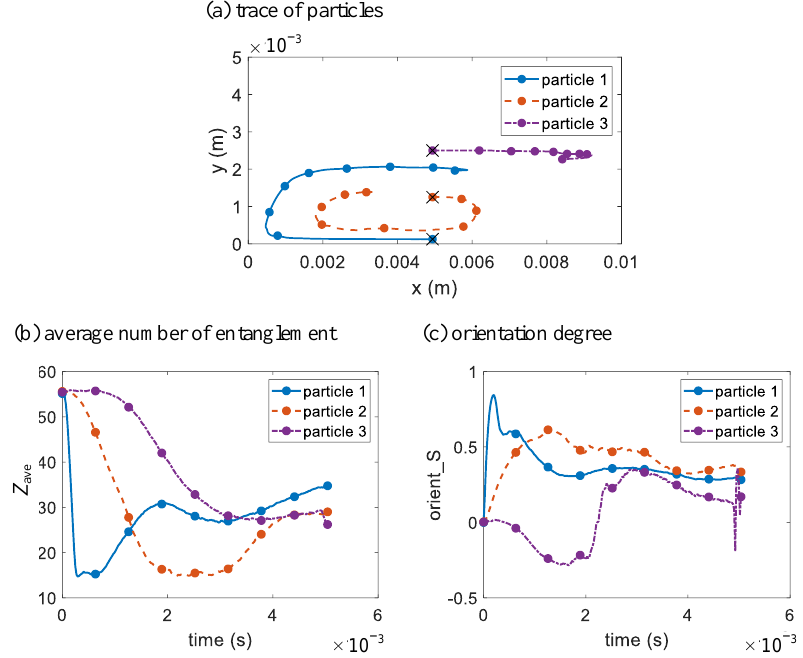
Figure 7. The multiscale simulation results of ( a ) particle traces and the changes in ( b ) average number of entanglements and ( c ) orientation degree over time of 3 chosen melt particles in the simple long rectangular cavity.